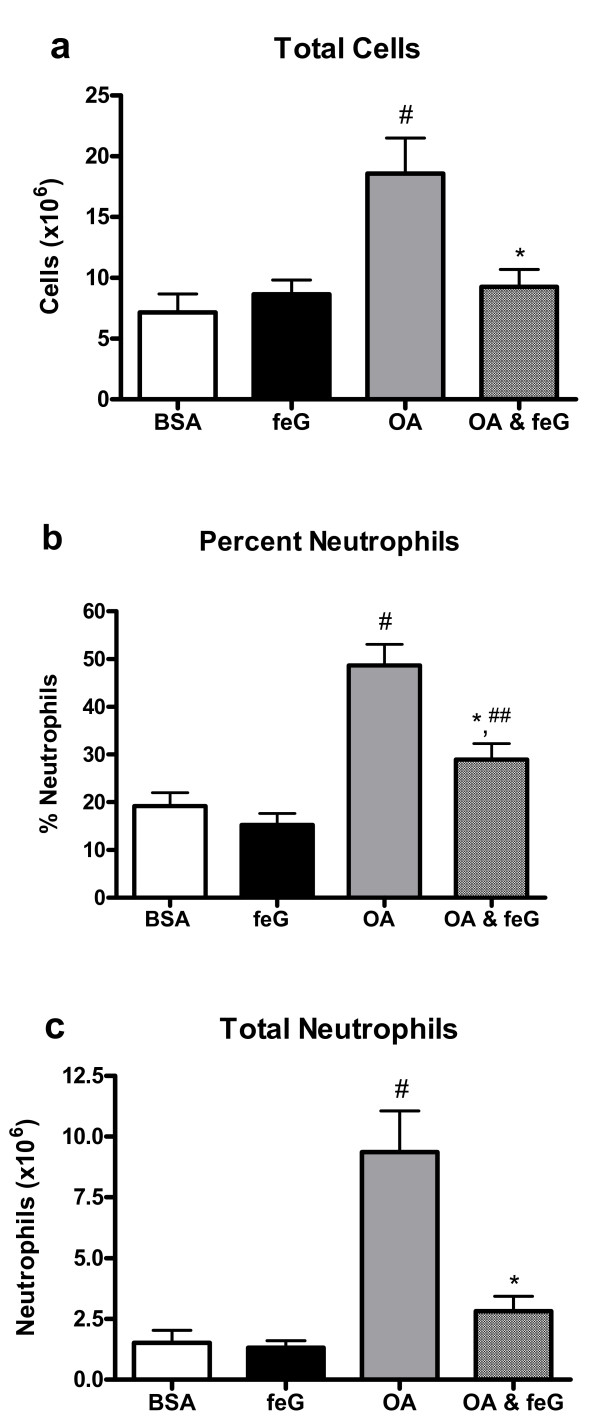
Leukocyte Counts. Total leukocyte numbers and the number and percent neutrophils in blood of sensitized rats 18 hours after receiving either naïve antigen (BSA□ n = 9), feG (■ n = 9), sensitizing antigen (OA; n = 11), or OA + feG (; n = 13). Challenge with sensitizing antigen (OA) increased the total number of circulating leukocytes, and this increase was prevented by feG (a). Antigen challenge increased significantly the percentage of circulating neutrophils (b), which is reflected in a dramatic increase in the total number of circulating neutrophils (c). These changes elicited by antigen challenge were inhibited significantly by feG. Significance: # > BSA; ## > feG;* < OA